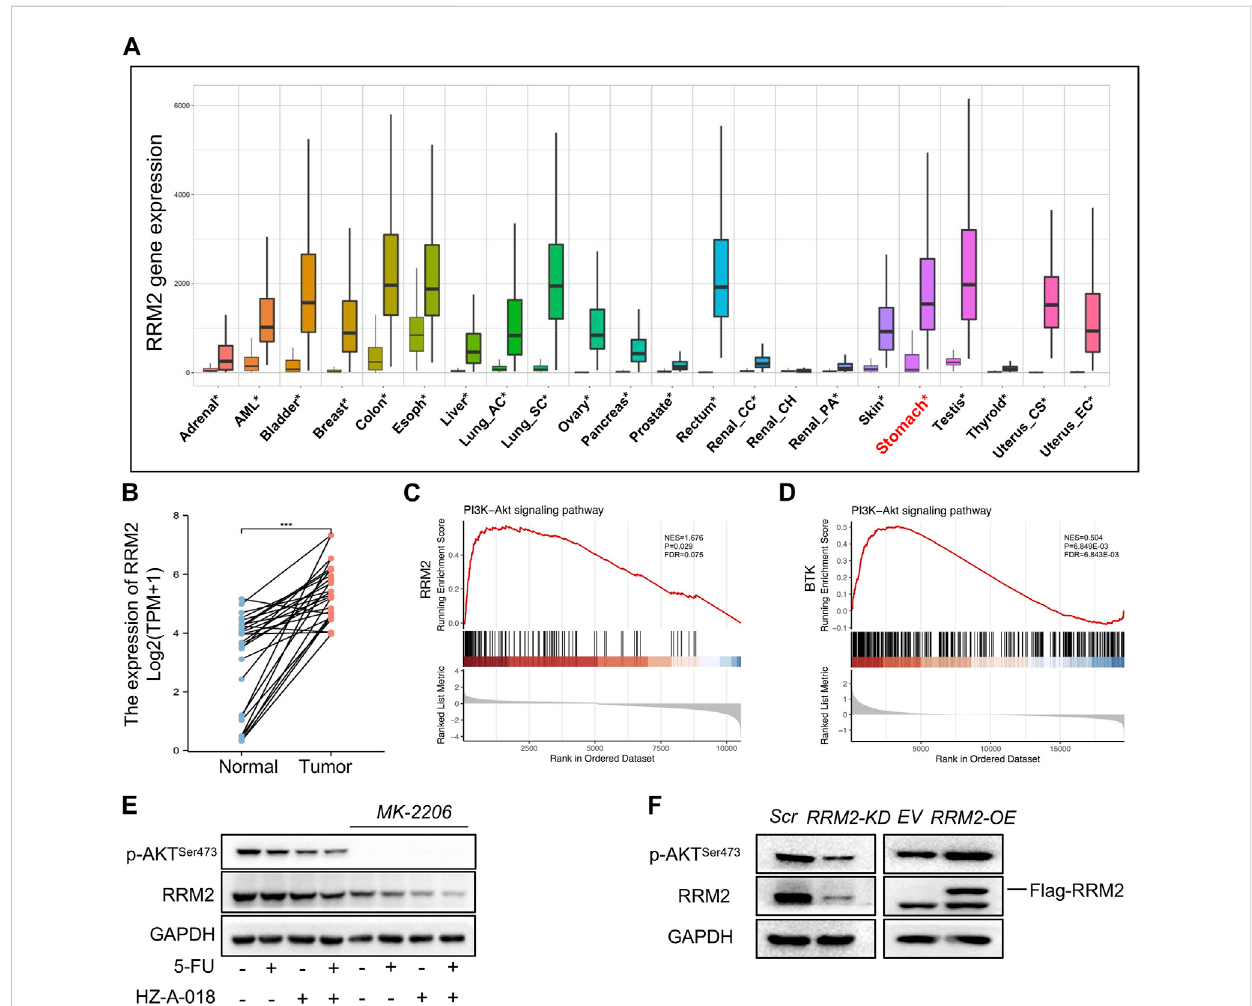
FIGURE 5 RRM2 expression in gastric cancer tissues and enrichment in PI3K pathway. (A) Differential expression of RRM2 in pan-cancer by RNASeq obtained from the TNMplot. Signi fi cant differences by Mann – Whitney U test marked with asterisk. (B) Paired expression of RRM2 for gastric cancer and adjacent normaltissue byRNASeqinGSE10072dataset. (C) PI3K/AKTpathway enrichmentplotsofRRM2obtained fromGSEA.NES,normalizedenrichmentscore of GSEA. p < 0.05 and FDR < 0.25 were considered statistically signi fi cant for GSEA. (D) PI3K/AKT pathway enrichment plots of BTK obtained from GSEA. p < 0.05andFDR < 0.25wereconsideredstatisticallysigni fi cantforGSEA. (E) TheeffectofMK-2206ontheexpressionofp-AKTandRRM2. (F) The effect of RRM2-OE (overexpression) and RRM2-KD (knocking down) on the expression of p-AKT and